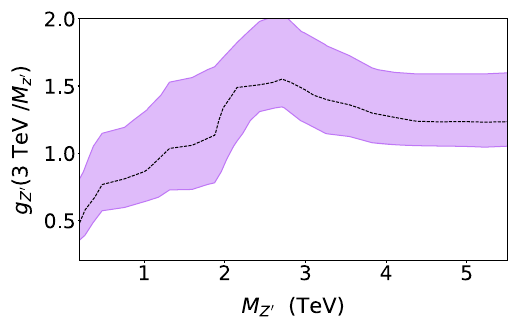
Fig. 18 Effects of theoretical uncertainties on bounds from the CMS di-muon search [62].The dashed black line shows the central limit. The purple region falls between bounds obtained from upper and lower estimates of the cross-section accounting for systematic uncertainties. Toward the extreme left-hand side of the plot, our predictions become more inaccurate due to unaccounted-for O ( M 2 tions